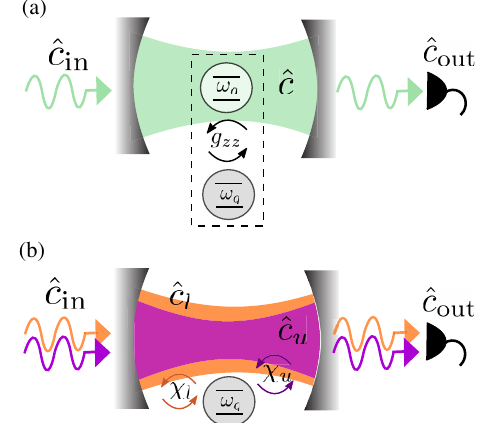
FIG. 1. Schematics of the circuit QED setup with the transmon molecule used for a high-fidelity and fast qubit QND readout. (a) A cavity mode ˆ c is strongly and transversely coupled to an ancilla system ˆ a , which in turn couples diagonally to the qubit ˆ σ ˆ a † ˆ a . (b) The strong hybridization between cavity and ˆ σ as ∼ g zz z ancilla is manifested by two orthogonal polariton modes ˆ c ˆ c , which couple to the qubit with a nonperturbative cross-Kerr l ˆ c † ˆ c ˆ c † ˆ c χ χ (see text). This allows us to infer coupling ∼ ˆ σ u z ð u u þ l l Þ l the state j g i or j e i of the qubit by measuring the resonance shifts of the polaritons at the cavity transmission